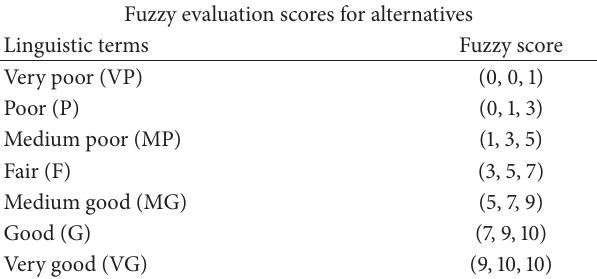
Table 1: Linguistic variable representing triangular fuzzy numbers. Fuzzy evaluation scores for